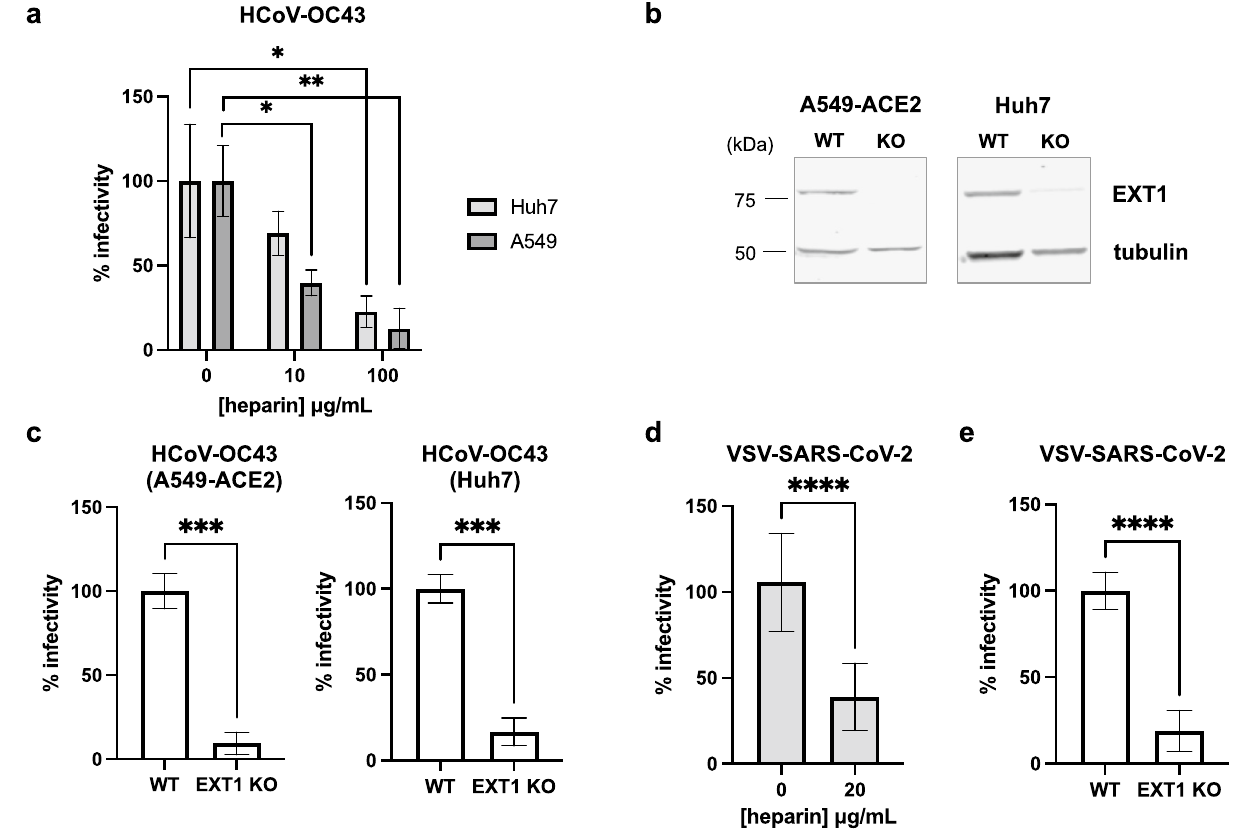
Figure 4. Heparan sulfate facilitates both SARS-CoV-2 and HCoV-OC43 infection. Pre-treatment of HCoV-OC43 ( a ) with heparin for 10 min at 37 °C reduced infection of Huh7 and A549 cells. ( b ) Western blot showing KO of EXT1 in A549-ACE2 and Huh7 cells. ( c ) HCoV-OC43 was titrated on WT and EXT1 KO cells, revealing reduced susceptibility of EXT1 KO cells to infection. ( d, e ) VSV-SARS-CoV-2 infection of A549- ACE2 cells is reduced by heparin pre-treatment or in the absence of EXT1. Mean values with standard deviation of three independent experiments are plotted. Statistical significance was assessed by Welch’s t test (* p < 0.05, ** p < 0.01, *** p < 0.001, **** p <